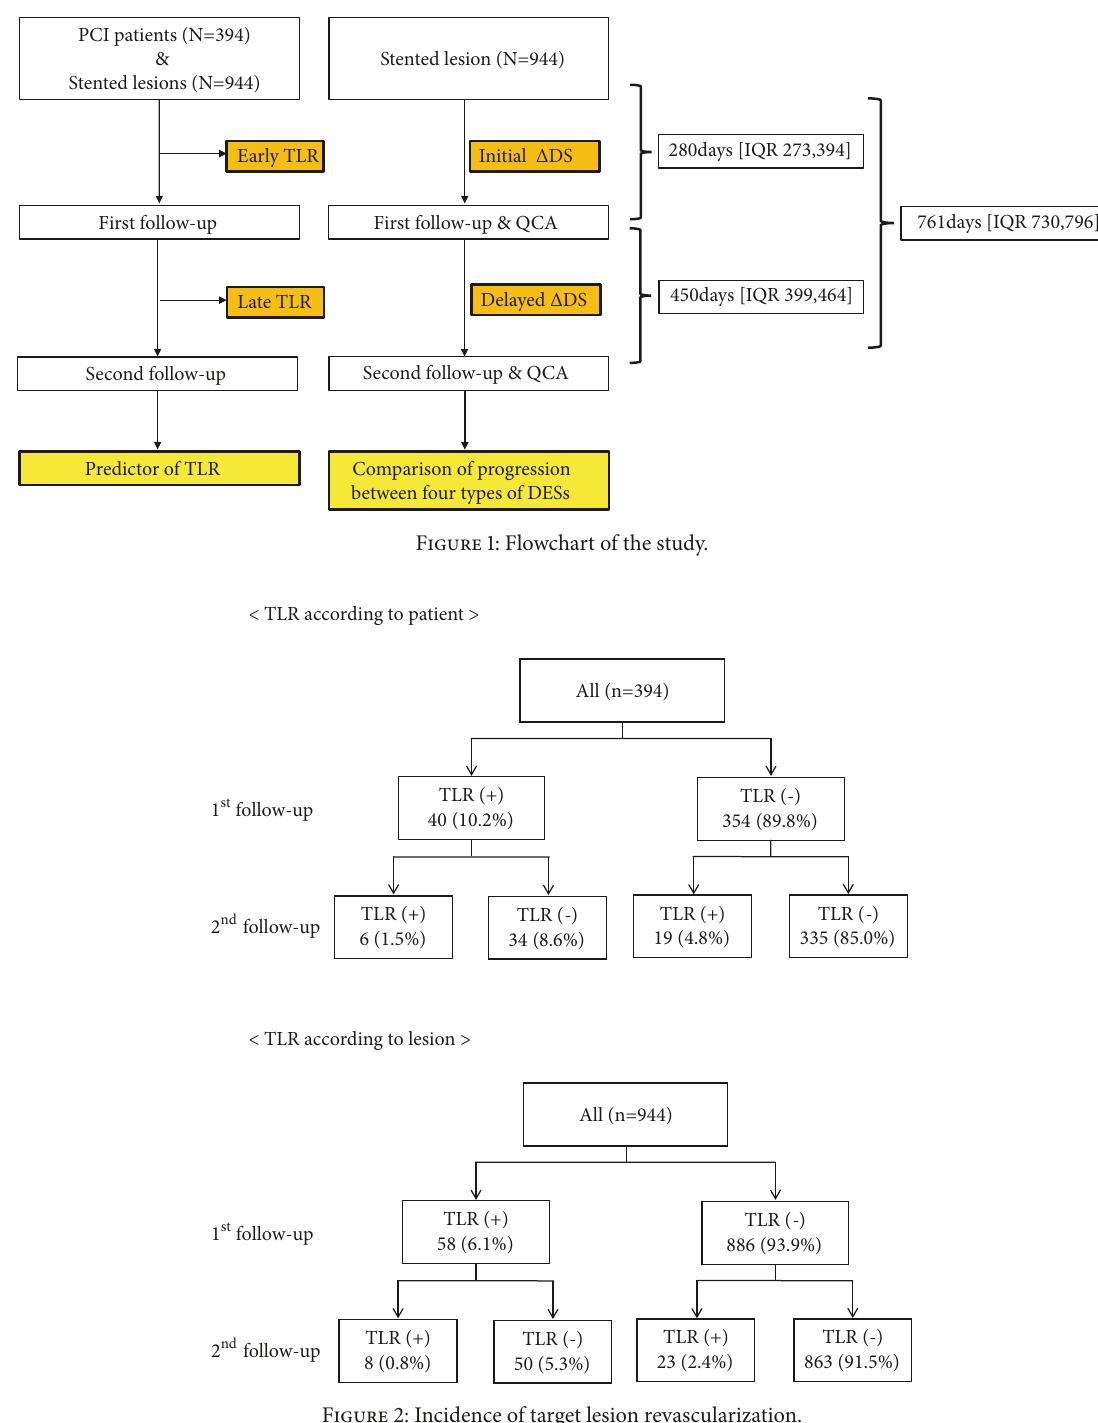
multivessel disease, left ventricular dysfunction, hemoglobin, CRP as clinical factors and lesion type B2/C, reference vessel diameter, lesion length, preprocedure DS%, and postproce- dure DS% in-stent as lesion-related factors. Statistical analysis was performed with SPSS (version 23.0), and a value of P values less than 0.05 was considered statistically